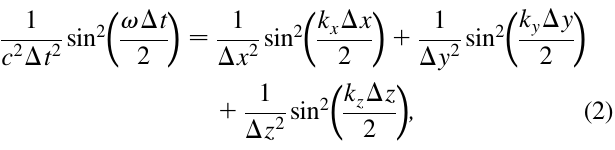
FIG. 4. Numerical phase velocity along x [ v from Eq. (2)] as a function of k modes propagating in the x - y plane ( k plane corresponds to v is representative of particles having an energy of 120 MeV).